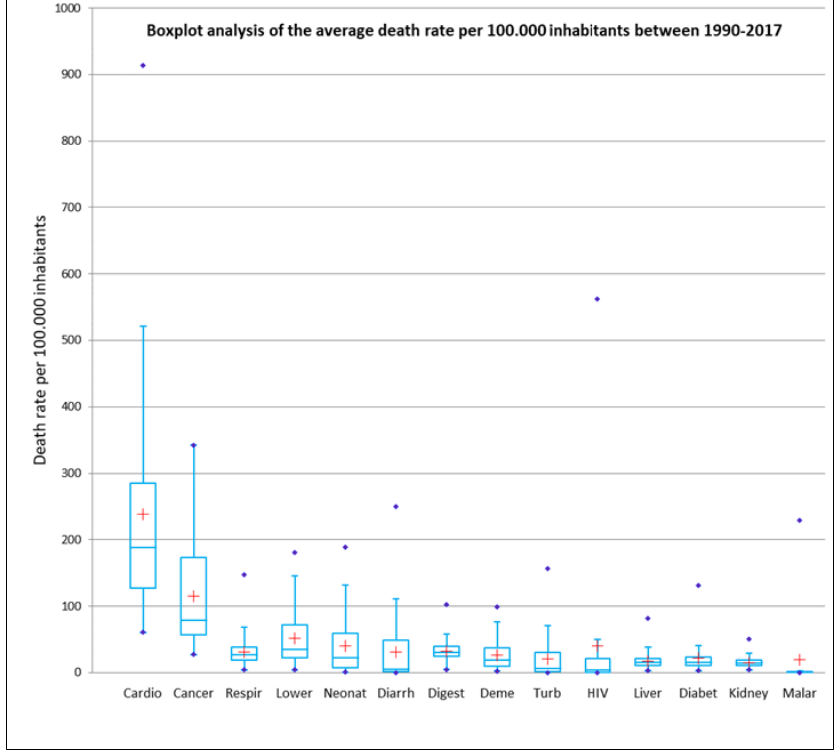
Figure 3. Representative Boxplot analysis for data interpretation. Source of data: The Institute for Health Metrics and Evaluation, World Bank.